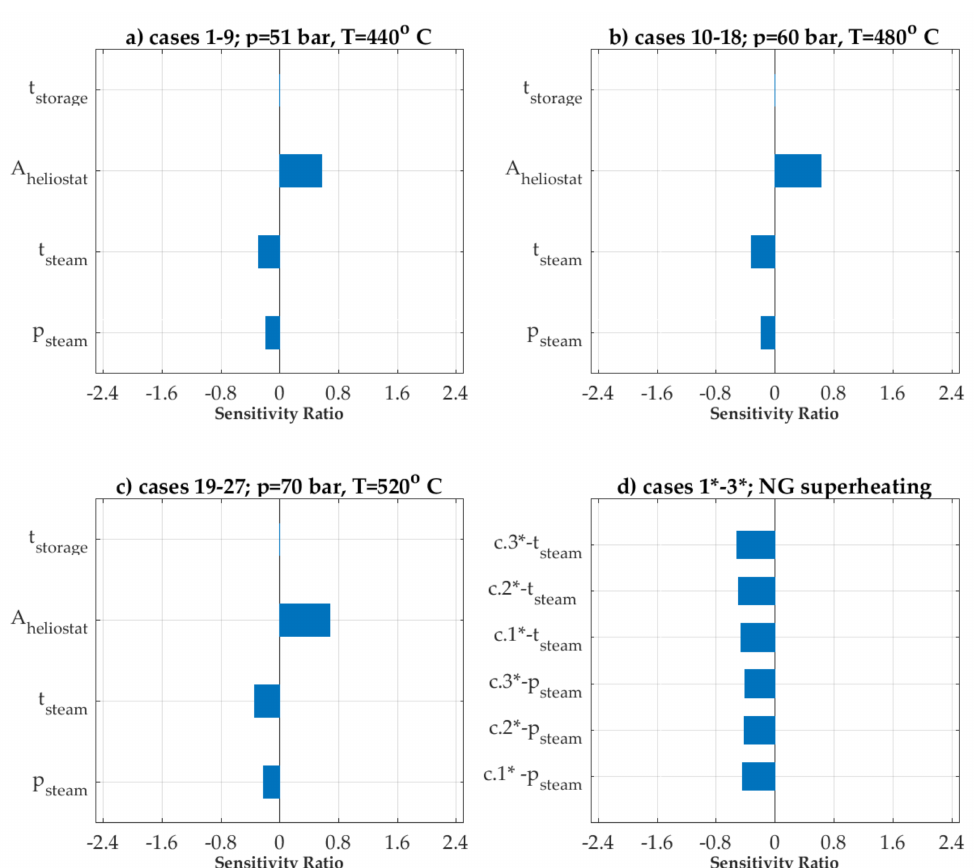
Figure 8. Sensitivity Ratio of exergy cost for the analyzed cases ( a – d ).